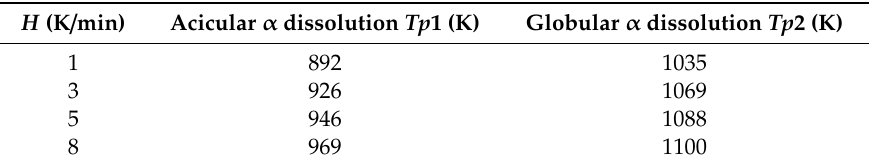
Table 4. The measured peak temperatures of bimodal Ti-55531 at various heating rates.